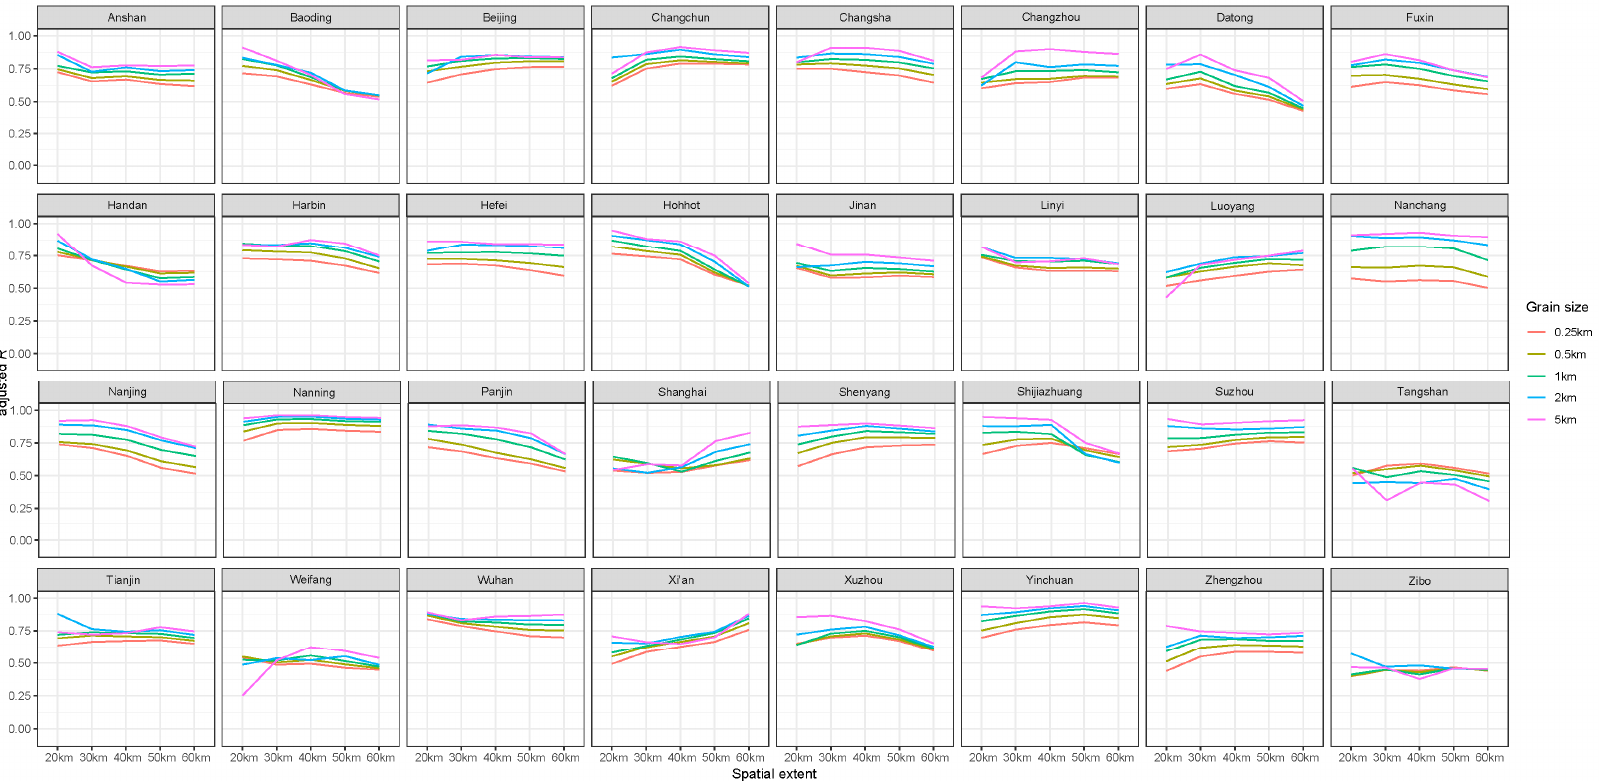
Figure A12. Collective explanatory power for explaning LST(Scalogram of the spatial extent)